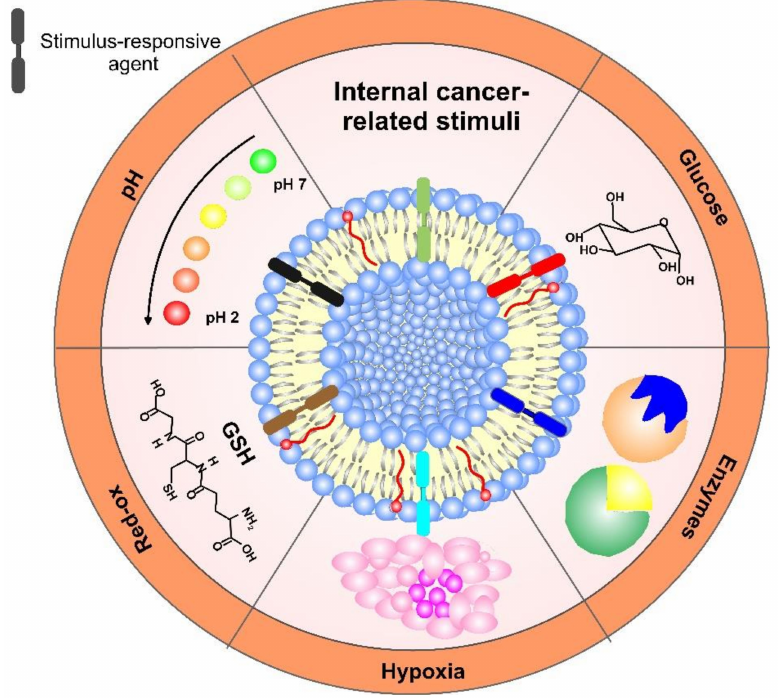
Figure 6. Internal cancer-related stimuli used for the stimuli-triggered release of drug-loaded